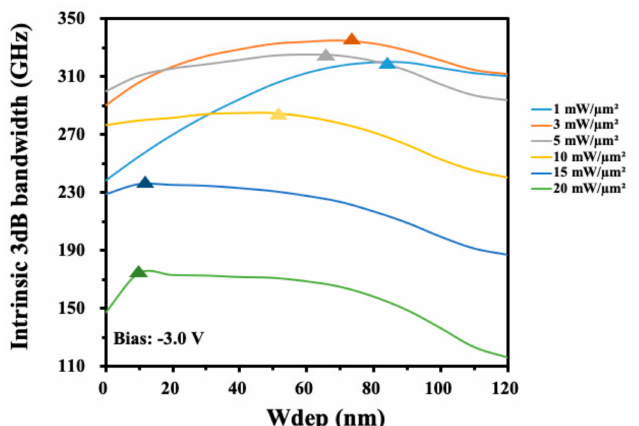
Figure 6. Simulated intrinsic 3 dB bandwidth of the MUTC-PD with varying hybrid absorber structures. The thickness of the depleted InGaAs absorber layer Wdep varies from 0 to 120 nm, and the optical input power density is set to 1, 3, 5, 10, 15, and 20 mW/ µ m 2 , respectively (bias voltage − 3